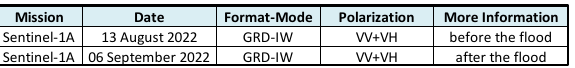
Table 1 . Specifications of Sentinel-1 images